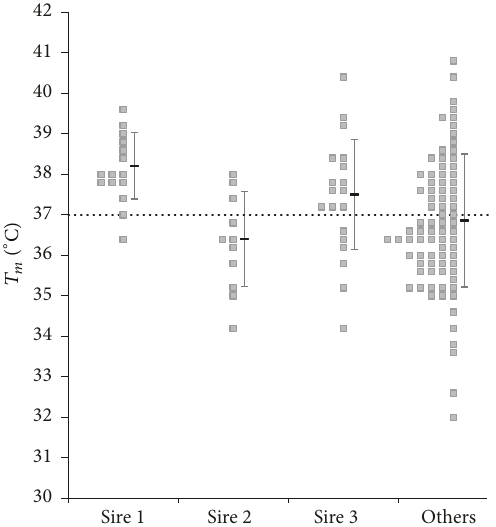
Figure 1: 𝑇 𝑚 distributions of Wagyu carcasses differ by sire. The melting temperature of intramuscular fat samples taken from between the 10thand11thribof126carcassesoffullbloodWagyusteers.Allanimalswerefedthesamerationfor 300±20 days.Individual 𝑇 𝑚 measurements of carcasses are grouped by sire (mean and standard deviation). Animals with either an uncertain sire or a sire with less than 10 progeny are grouped under “other” sires. Progeny of Sire 3 shows considerable scatter, whereas 8/11 of those of Sire 2 are below 37 degrees compared with 1/15 in the case of Sire 1. The difference between Sire 1 and Sire 2 is statistically significant with a chi-square statistic of 12.2 and thus a 𝑝 value < 0.01.